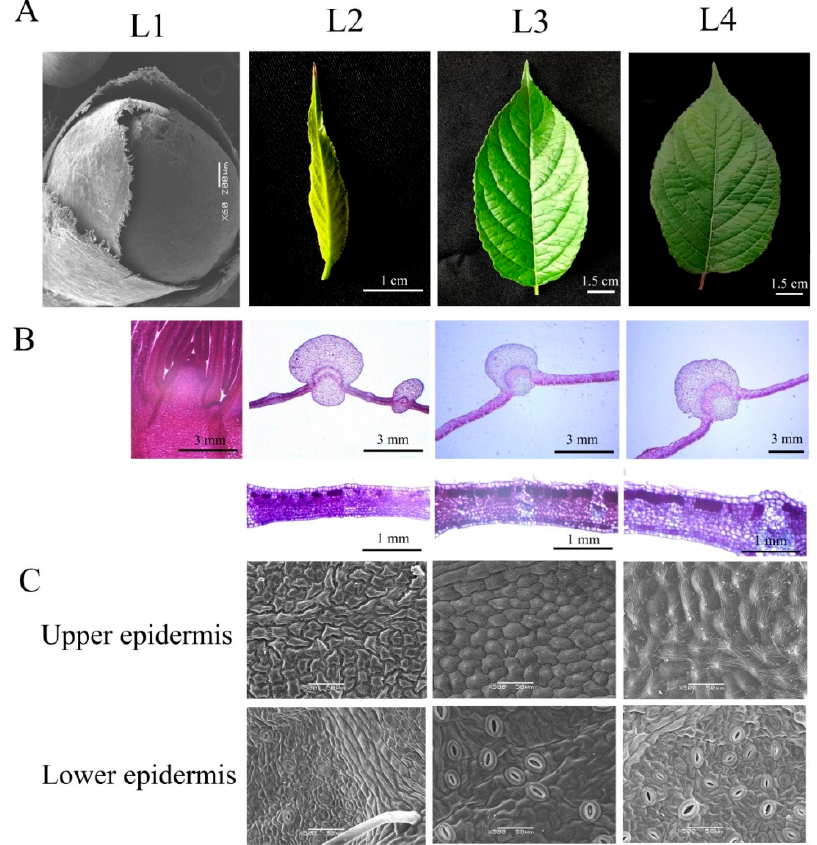
Figure 1. Morphological characterization of Eucommia ulmoides leaves at different growth stages. ( A ) Developmental process of E. ulmoides leaves. ( B ) Cross-sections of leaf buds and leaves. ( C ) Morphological characterization of the leaf epidermis.